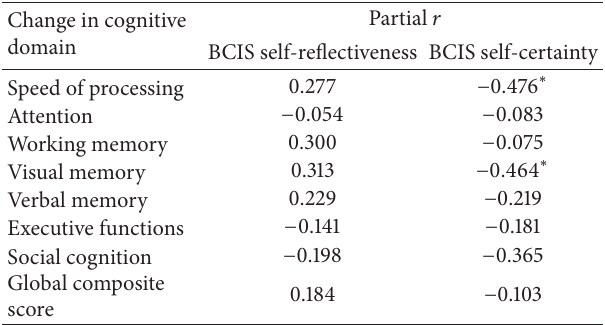
Table 3: Partial correlations between change in cognitive perfor- mance and baseline insight